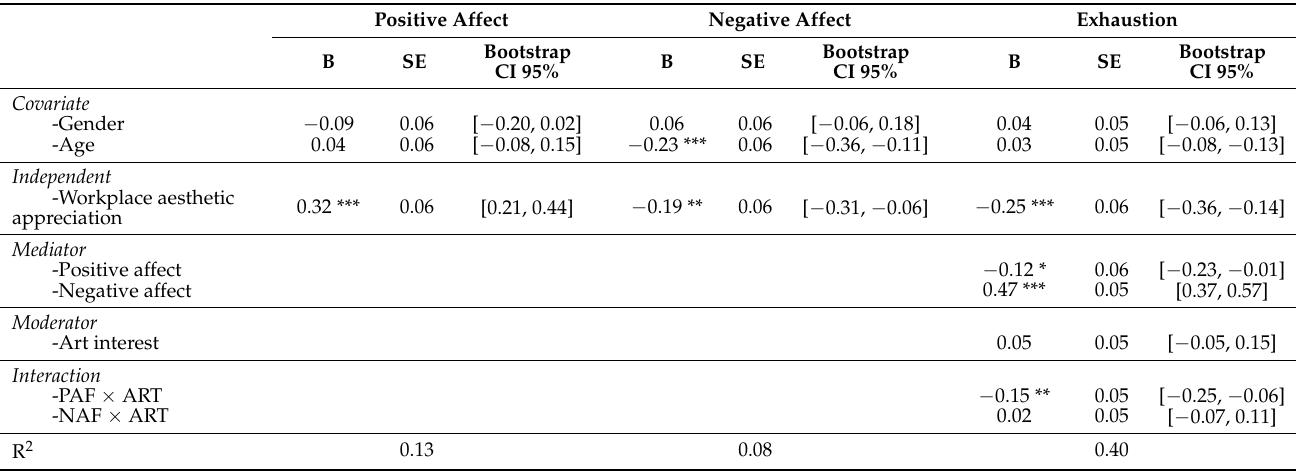
Table 2. Moderated mediation